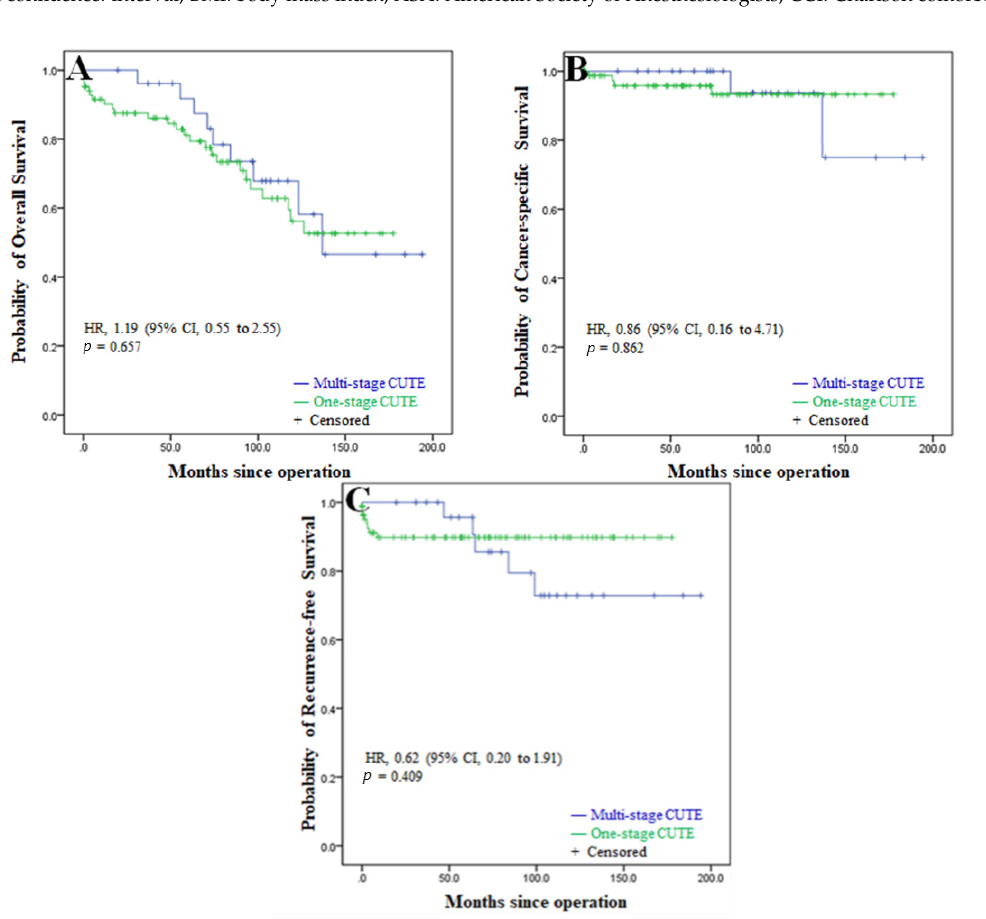
Figure 2. Kaplan-Meier estimates of ( A ) overall survival, ( B ) cancer-specific survival, and ( C ) recurrence-free survival in dialysis patients with urothelial carcinoma undergoing one-stage CUTE versus multi-stage CUTE. HR, hazard ratio; CI, confidence interval; CUTE, complete urinary tract extirpation.